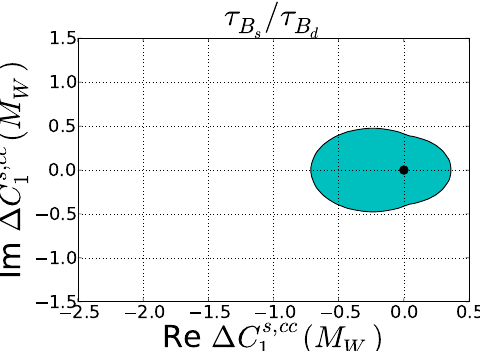
Figure 13 . Potential regions for the NP contributions in (cid:1) C s;cc by the life-time ratio (cid:28) B =(cid:28) B at 90% C.L. . Here we assumed only BSM contributions to the decay s d channel b ! c (cid:22) cs , but none to b ! c (cid:22) ud . The black point corresponds to the SM